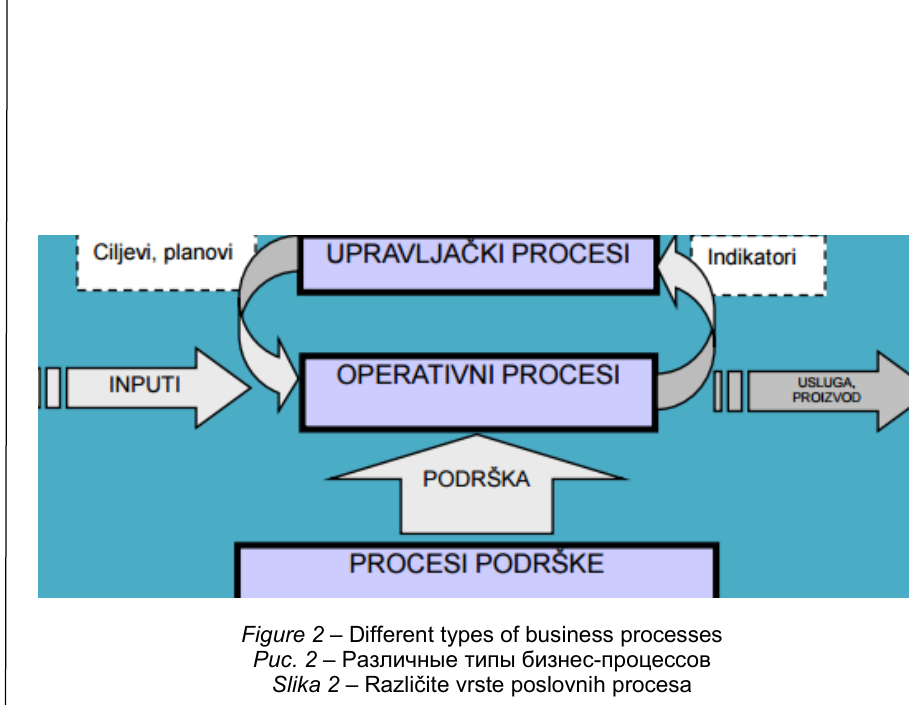
Figure 2 – Different types of business processes Рис . 2 – Различные типы бизнес -